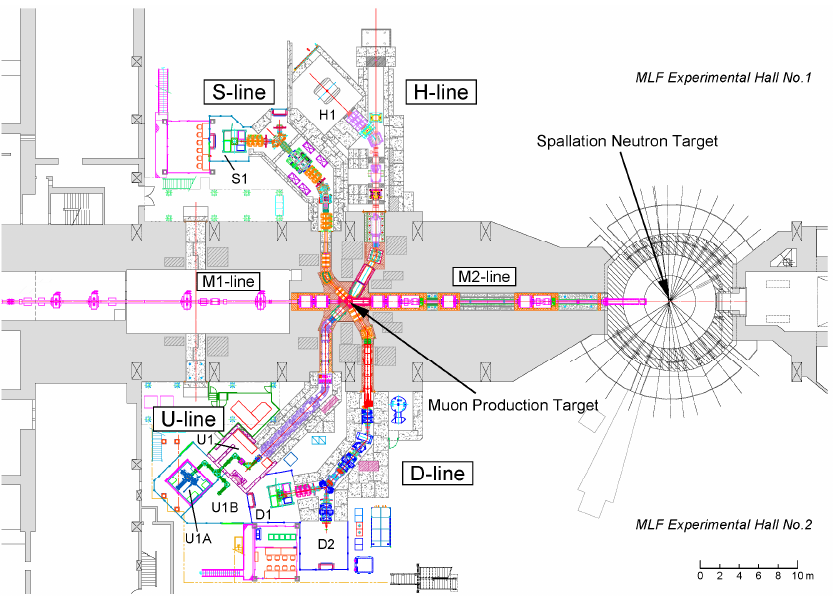
Figure 6. Floor plan of the muon beamlines (provisional for the H-line) in the MLF building. Four beamline tunnels, one each for the D-, U-, S-, and H-lines, surround the muon production target.